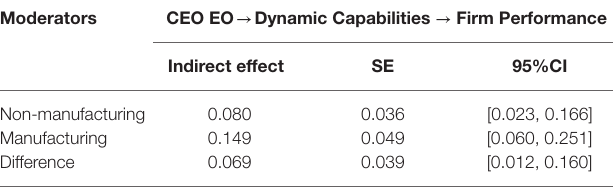
TABLE 3 | The results of moderated